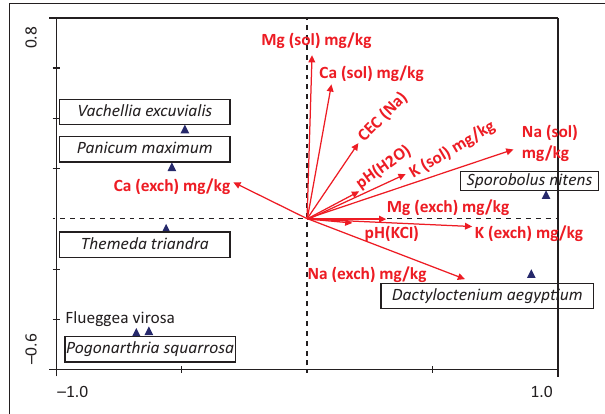
FIGURE 3: Simple ordination diagram of the canonical correspondence analysis (first and second axes) showing the relationships between selected species’ cover abundance, soil texture and soil forms. The eigenvalues of the respective axes were 0.642 for axis 1 and 0.523 for axis 2.